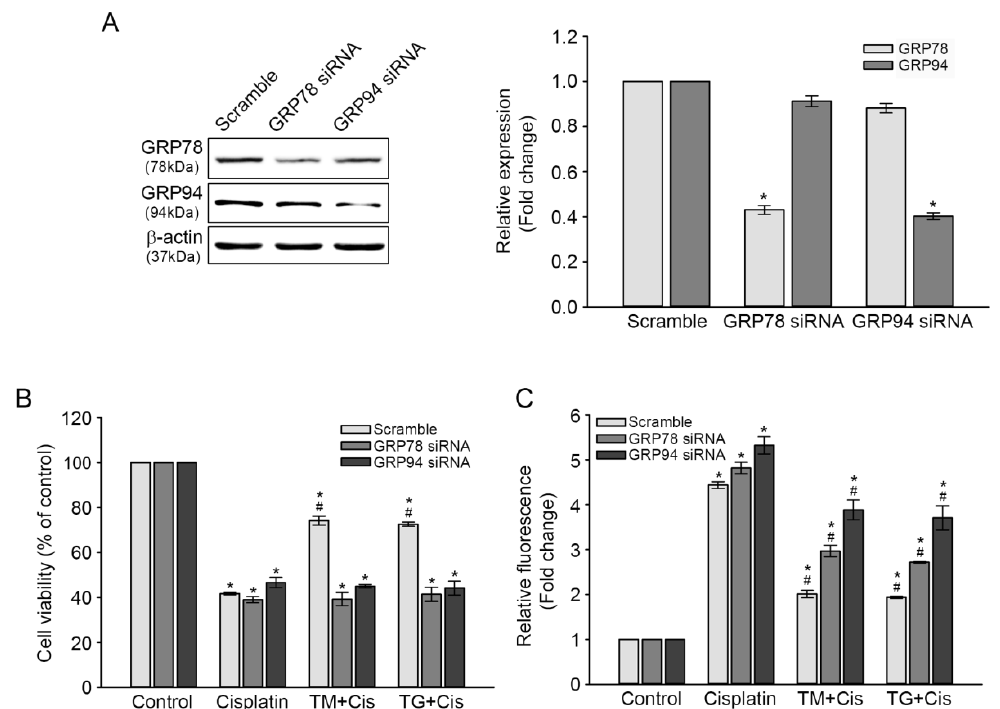
Figure 5. Cisplatin-mediated cytotoxicity and intracellular ROS accumulation in GRP78 or GRP94 KD cells. Cells were transfected with GRP78, GRP94, or scrambled siRNAs and then treated with cisplatin as described in Section 2. ( A ) GRP78 and GRP94 expression levels after the 72-h transfection. Protein bands were quantified densitometrically and normalized to the density of the β -actin band. The ratio of GRP78 or GRP94 to β -actin in each group was presented as its fold-change relative to the scrambled siRNA transfectant. * p < 0.05, compared with the scrambled siRNA transfectant. After the 48-h incubation, cells were treated with TM or TG, and then cisplatin, as previously described. ( B ) Cell viability was determined through CCK assay. The graph represents the relative viability percentage, compared with the untreated control. Values are expressed as means ± SE of three independent experiments. p < 0.05, *; compared with the untreated control, # ; cisplatin-only versus TM plus cisplatin or TG plus cisplatin. ( C ) The levels of ROS accumulation were determined through DCF fluorescence intensity spectrofluorometry. The graph represents the relative ROS accumulation fold, compared with untreated controls. Values are expressed as means ± SE of three independent experiments. p < 0.05, *; compared with the untreated control, # ; cisplatin-only versus TM plus cisplatin or TG plus cisplatin.